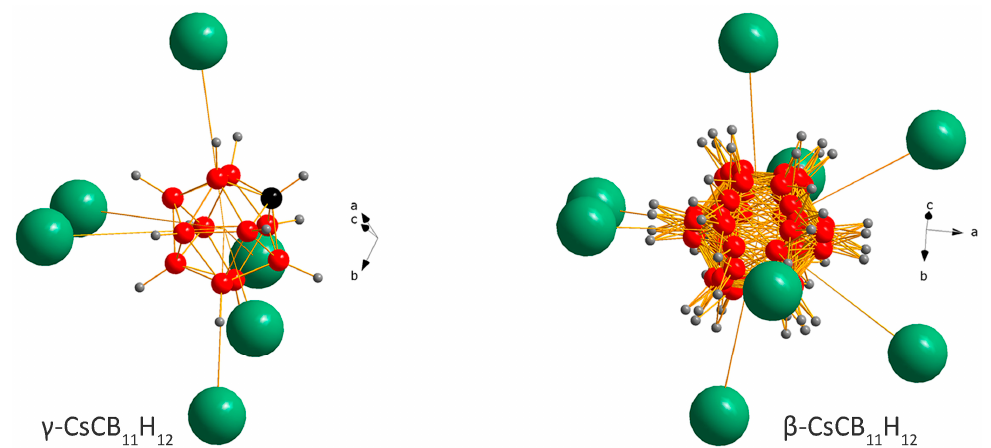
Figure 4. Coordination of the CB 11 H 12 − anion in the crystal structures of γ - and β -CsCB 11 H 12 . The γ -structure as obtained from single-crystal data [8] is optimized here with DFT also allowing carbon localization. While the anion is ordered in the former, it is rotationally disordered in the latter. The water molecules in hydrated phases occupy the channels on the right side from the anion in γ and share the positions with Cs atoms in the ratio 1:3 in β